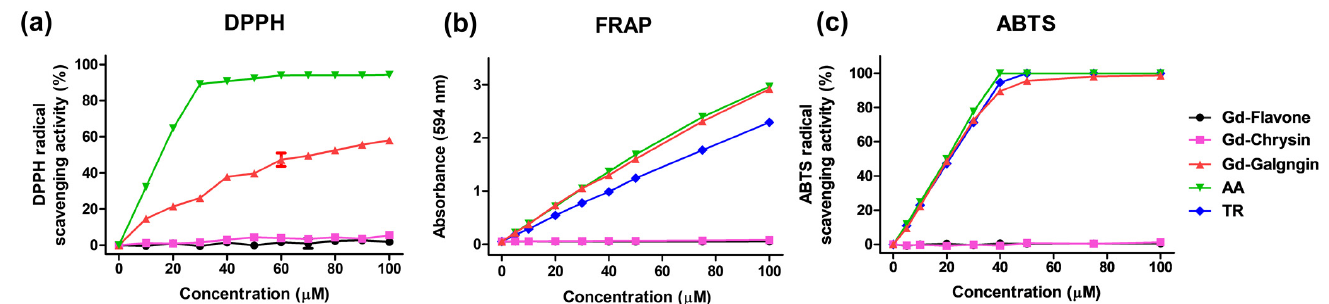
Figure 3. Radical scavenging activity of Gd-flavone, Gd-chrysin, Gd-galangin, ascorbic acid (AA) and trolox (TR). ( a ) 2,2-Diphenyl-1-picrylhydrazyl (DPPH), ( b ) Ferric-Reducing Antioxidant Potential (FRAP), ( c ) 2,2 (cid:48) -Azino-bis (3-ethylbenzthiazoline-6-sulphonic acid